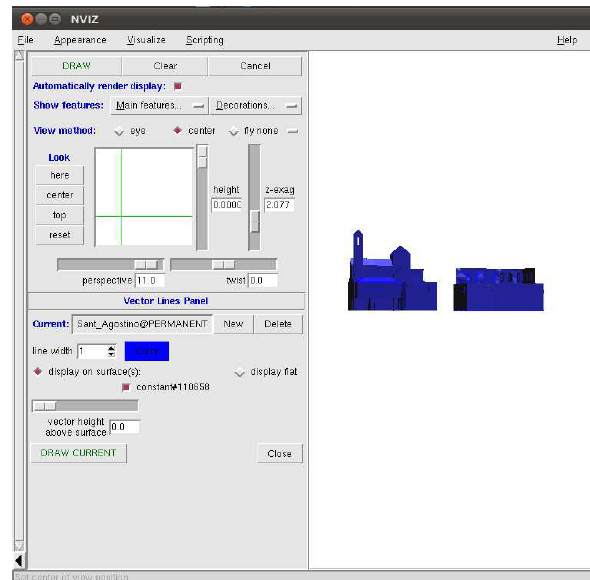
Figure 13. S. Tommaso and St. Agostino: 3D models in NVIZ